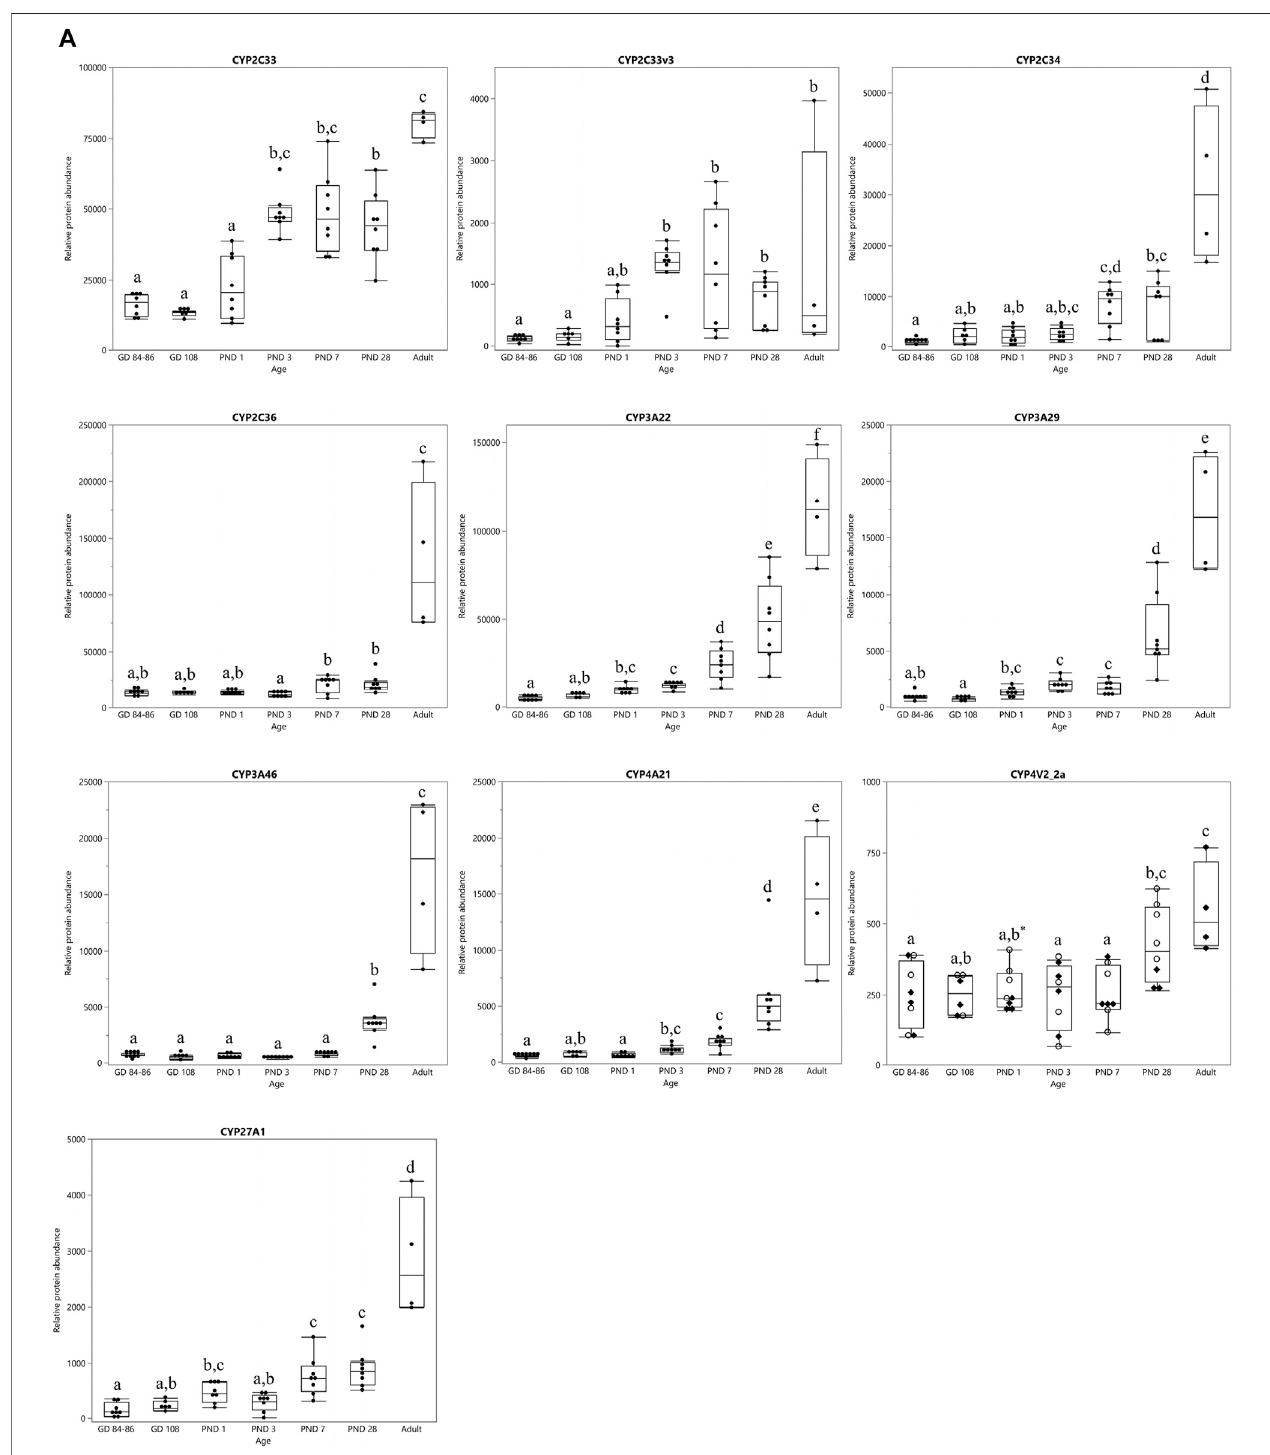
FIGURE 3 | CYP protein abundance maturation pro fi les over time in the developing and adult male Göttingen Minipig. Different ontogeny patterns were observed: CYP enzymes with a gradual postnatal increase (A) , CYP enzymes that reached their maximum value at PND 28 (B) , CYP enzymes with a stable expression over time from thefetalstageuntiltheadulthood (C) and oneatypical CYPisoformwithhighlevels inthefetalstagesthatdropped during the fi rstmonth oflifeand increasedagain in the adult (D) . In case ofsex-related differences a distinction ismade between female ( ○ ) and male ( ◆ ) animals, when no sex-related differences are present both sexesarerepresentedbythesamesymbol( C ).Theboxplotsrepresentthemean,25thand75thquantiles,theupperandlowerwhiskersindicatethehighestandlowest datapoint, respectively, that lies within the 1.5 interquartile range. Datapoints that lie beyond the whiskers are outliers. Statistically signi fi cant age-related differences are indicated by characters ( p < 0.05), statistically signi fi cant sex-related differences are indicated by *( p < 0.008).